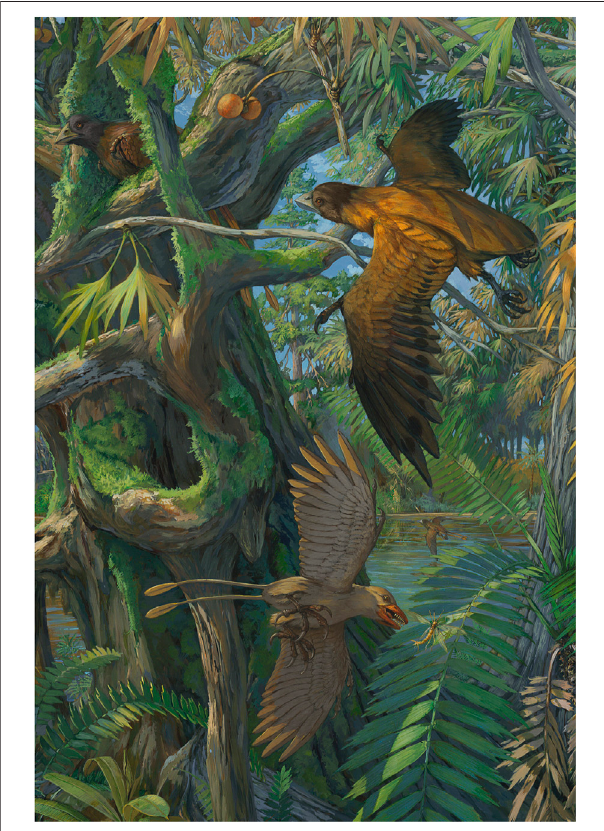
FIGURE 1 | Illustration of the Early Cretaceous Jehol avifauna depicting Confuciusornis (Wu et al. and Zheng et al.) together with a bohaiornithid enantiornithine (Liu et al.). Artwork by Michael Rothman.